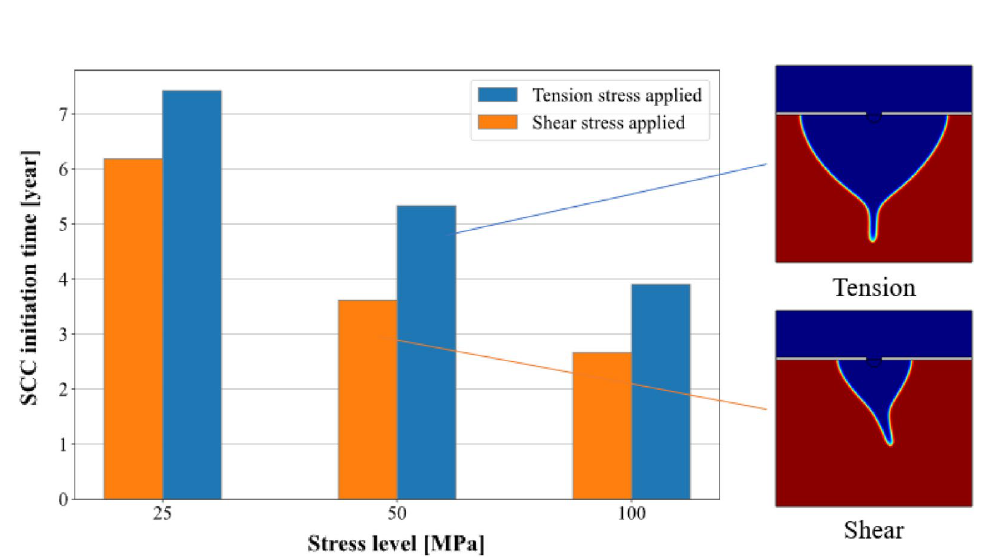
Figure 13. Stress influence on SCC